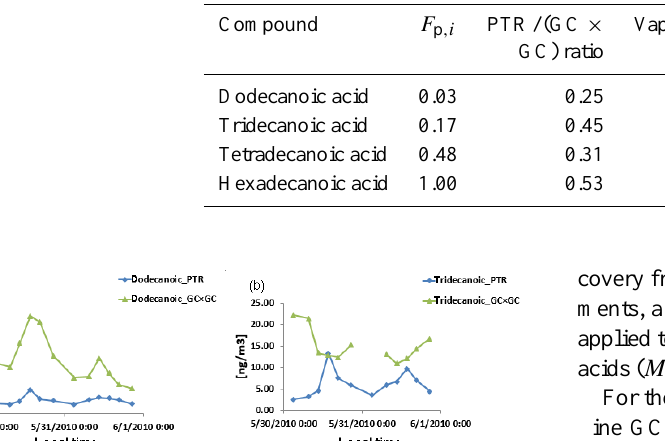
Table 2. Calculated partitioning coefficients F p ,i , observed PTR/(GC × GC) ratios averaged over the considered period, vapour pressures of dodecanoic, tridecanoic, tetradecanoic and hexadecanoic acids, and correlation coefficients ( r ) of the TD-PTR-MS and the GC × GC measurements of the acids.